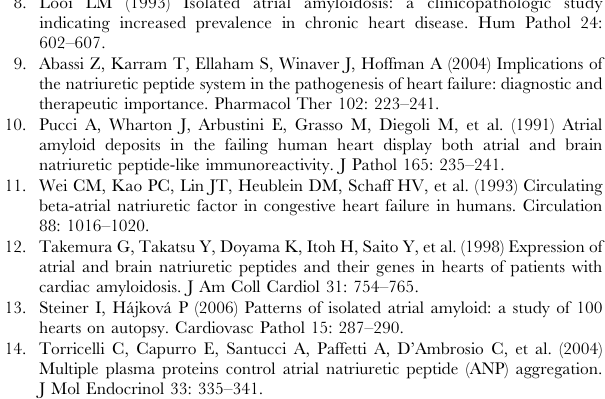
Figure S4 Formation of a -ANP oligomers and aggre- gates monitored by Tris-tricine SDS-PAGE. A ) a -ANP solution in H2O at pH 7.4 at different aggregation times; B ) a - ANP solution in H 2 O at pH 4.0 at different aggregation times; an appreciable difference in oligomers size and distribution between the two tested solutions was evident. Arrow indicates monomer, asterisk indicates dimer and # indicates high molecular aggre- gates. Figure S5 Microscope observations. A ) CHF-ANP incu- bated at pH 7.4; Images show branched fibrils indicating that they are composed of interwined protofibrils and aggregates composed of fibrils with apparent different morphology. B ) TEM micro- graphs of a -ANP incubated at pH 7.4: images show several fibrils that lie almost parallel and close to one another. One or more protofilaments unwinding from a fibril and winding onto an adjacent one are also observed. On the right, light microscopy of the a -ANP assembly is shown; CR brightfield (Magnification 20X); C ) TEM observations of a -ANP incubated at pH 4.0 showing loose aggregates in which individual fibrils can be seen. Bundles of fibrils diverging from spherulites are evident. Figure S6 Effect of DTT addition on a -ANP incubated at pH 7.4 and pH 4.0. DTT is able to dose-dependently reduce the amount of amyloid fibrils formed under both pH 7.4 and pH 4.0 conditions. Figure S7 Electrophoresis. To model the conditions occur- ring in vivo in the heart of CHF patients, a mixture of ANP dimers and monomers (ratio 2:1) roughly as in CHF conditions, was settled up. Figure shows Tricine SDS PAGE of ANP in H2O pH 7.4. 1) Untreated sample; 2) Treated sample. Quali-quantita- tive image analysis was performed on silver stained gel by using Image Quant (Master) software to assess the obtaining of monomer/dimer 1 a -ANP:2 b -ANP ratio as shown in the Table. Figure S8 CR assay. A ) Spectral features of CR and aggregated a -ANP. Absorbance spectra of a suspension of a -